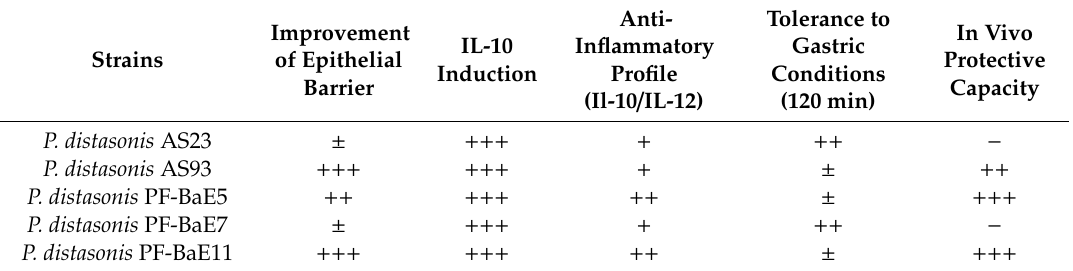
Table 2. Summary of statistically significant e ff ects of the P. distasonis strains in in vitro models and in vivo colitis